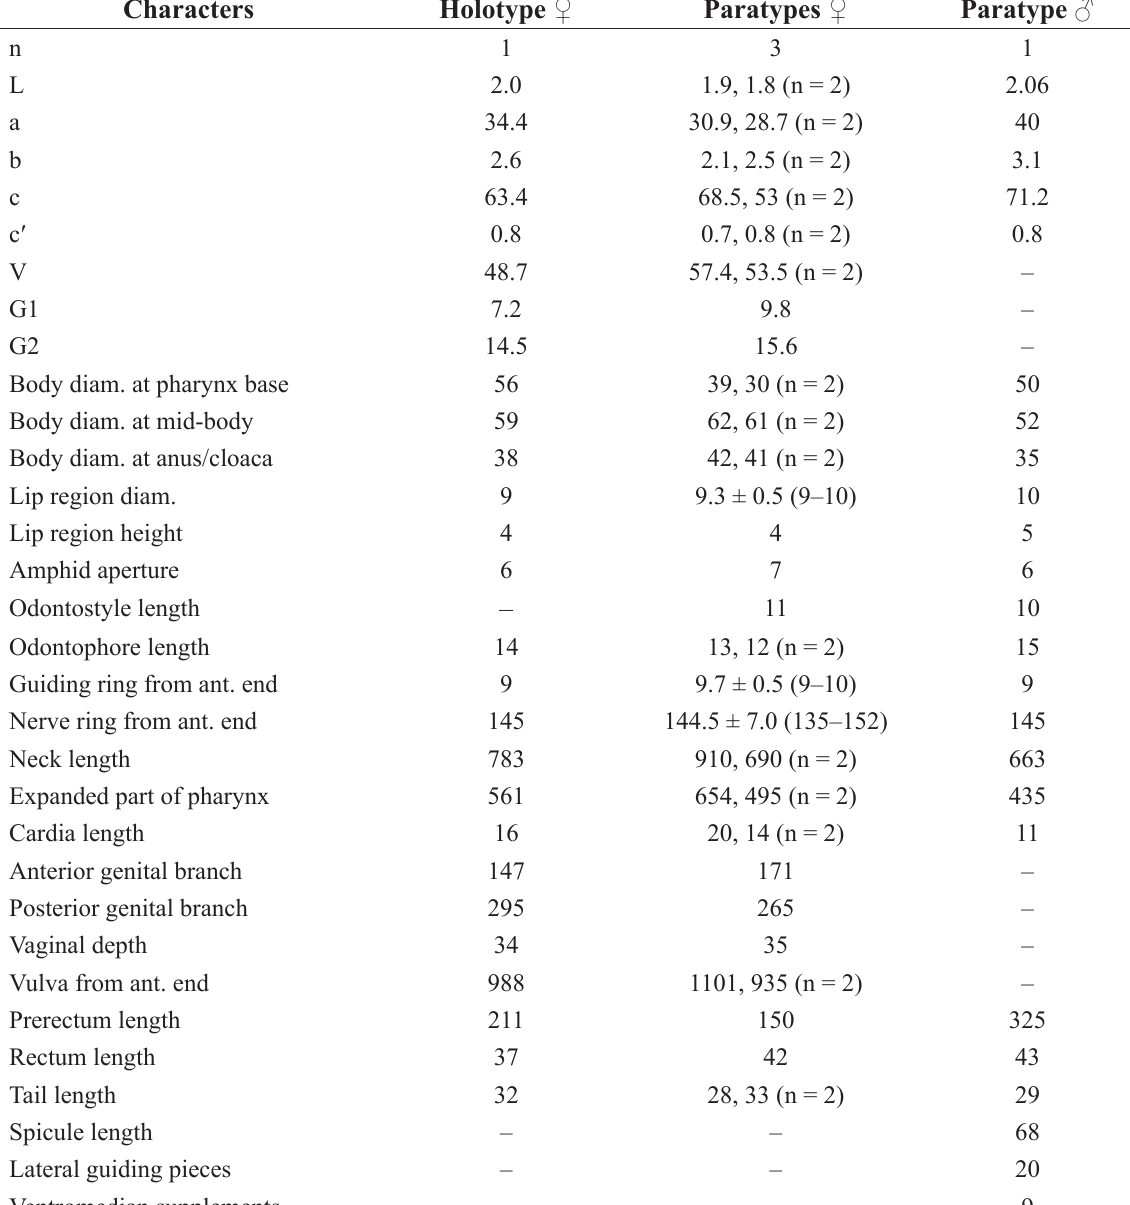
Table 10. Measurements of Axonchium uniqum sp. nov. All measurements in µm except L in mm, and in the form: mean ± s.d. (range), and measurements for each female (n = 2) separated by a